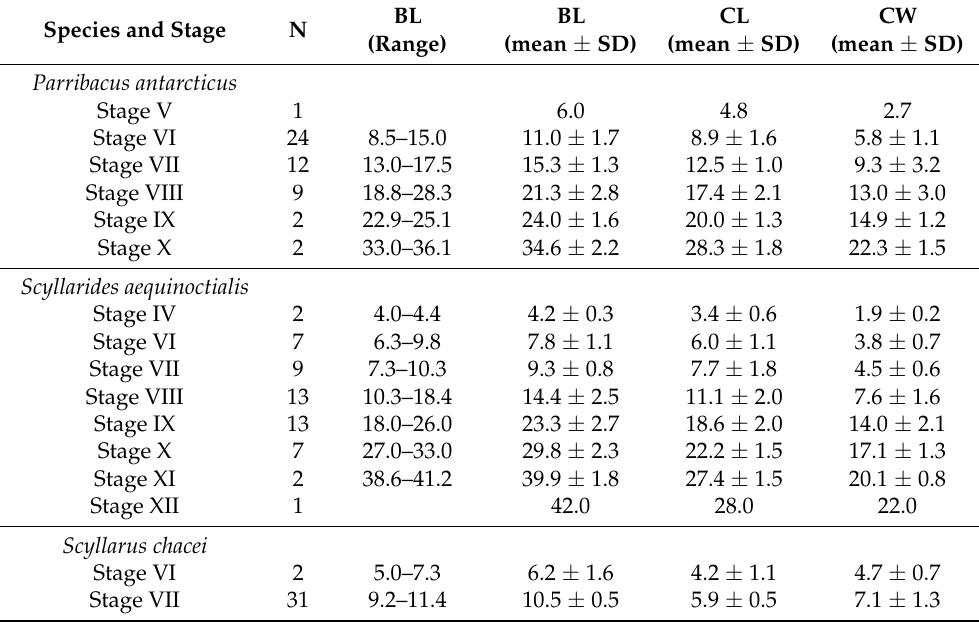
Table 4. Number of mid- and late stage scyllarid phyllosomata by species and stage (N), and morphometric measurements: BL (total body length), CL (cephalic length), CW (cephalic width). All measurements in mm. SD: standard